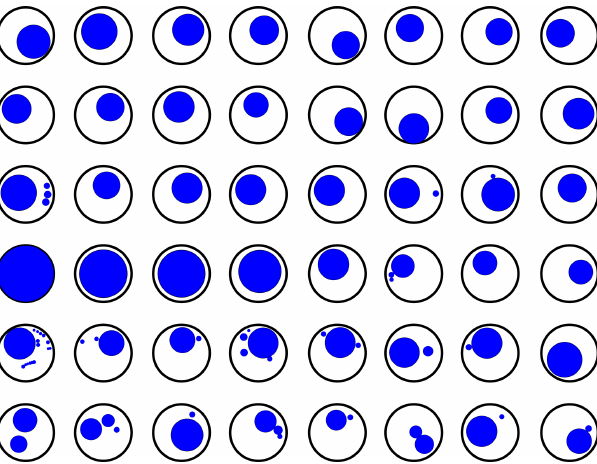
Figure 4. Top view (digitised facsimile) of the sample vials (black circles) turned upside down in order to illustrate the air/gas bubbles (blue circles) remaining in the vials after sample